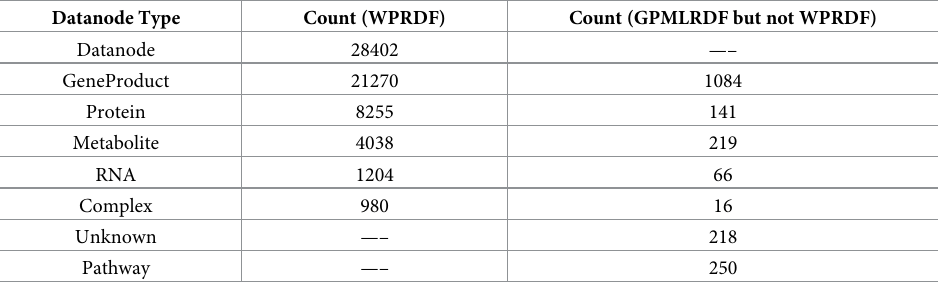
Table 2. Datanode type counts, as defined by the WikiPathways ontology. The datanode counts for each type of node found in the WikiPathways